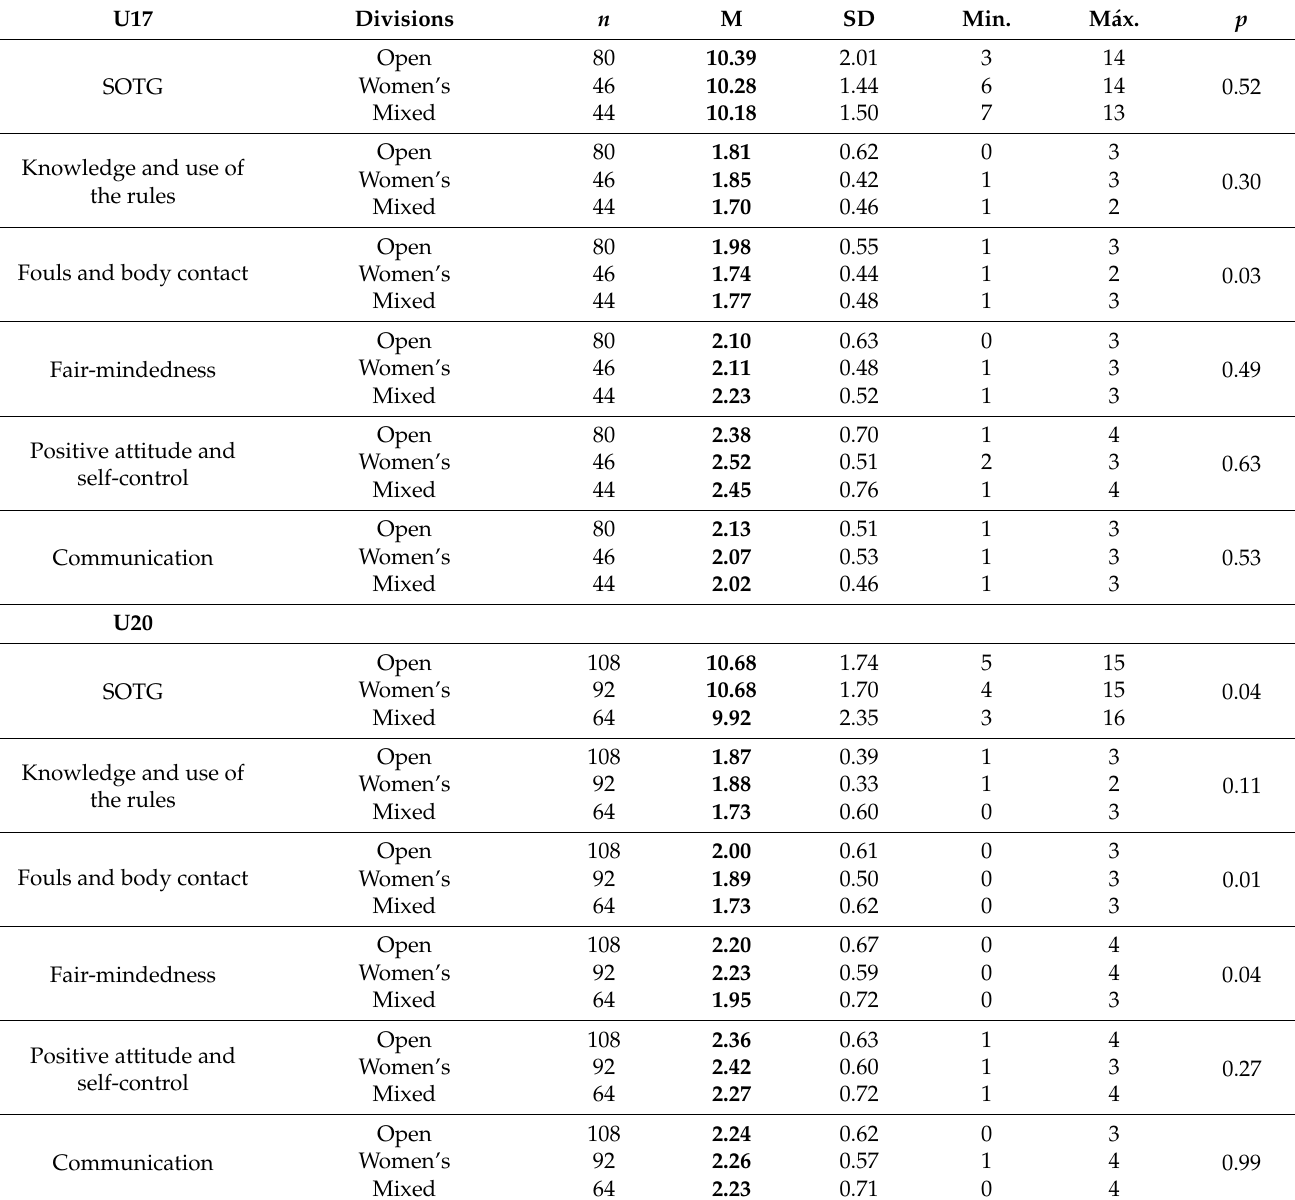
Table 2. Overall and detailed SOTG Scores for U17 and U20